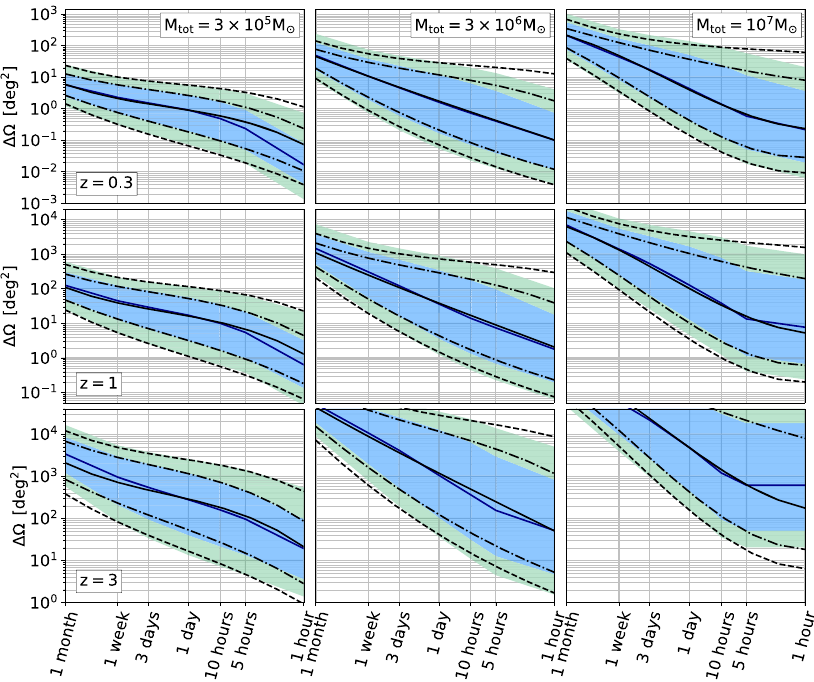
Fig. 26 Time evolution of sky position uncertainties from Fisher Matrix simulations, from Mangiagli et al. (2020), for different source-frame MBHB total mass and redshift. Blue lines correspond to the median of distribution, whereas blue and green areas correspond to the 68 and 95 percentiles, respectively. Overall, lower-mass systems are localized better than more massive MBHBs. At z ¼ 1, systems with total mass of 3 (cid:5) 10 5 M (cid:3) are localized within 10deg 2 10 h before merger. The same accuracy is reached for MBHB with 10 7 M (cid:3) total mass only 1 h before